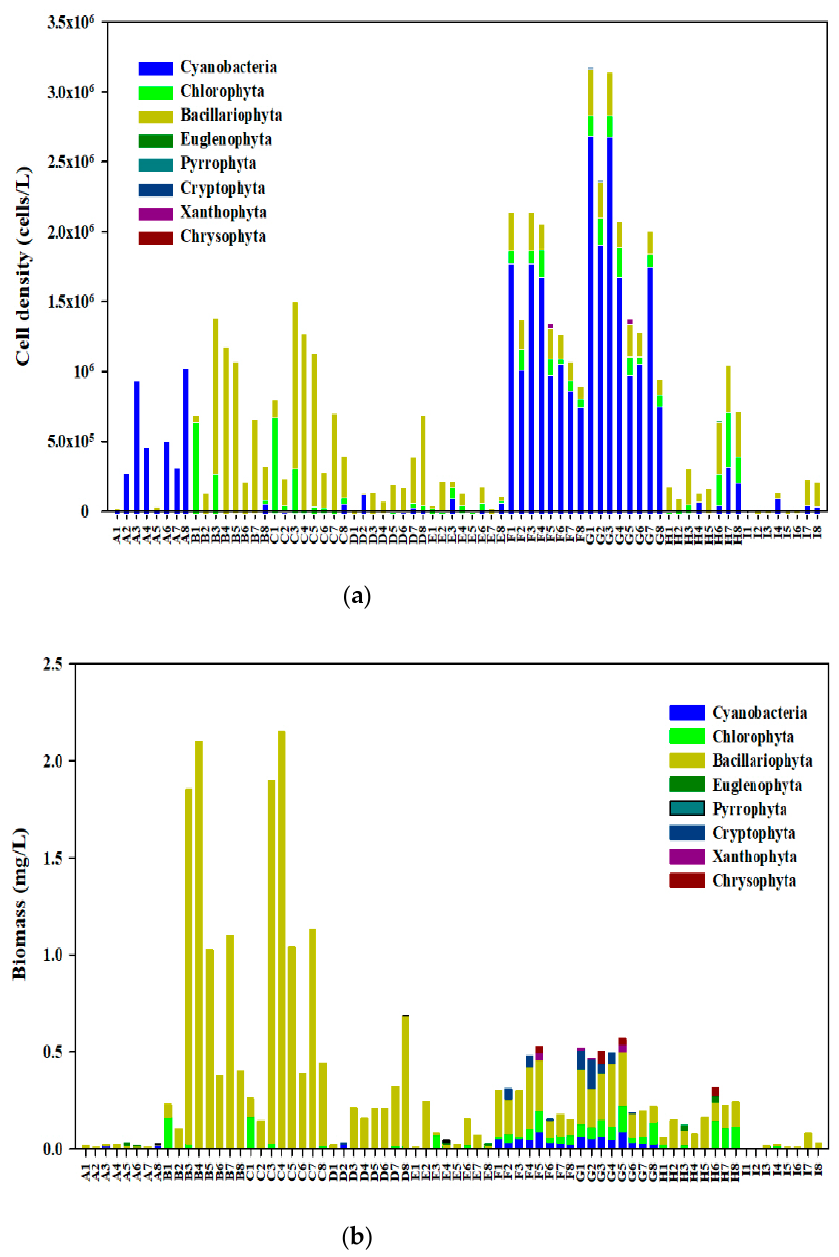
Figure 2. Variation of algae density ( a ) and biomass ( b ) in the reservoir. The dominance (Y) analysis of the dominant phytoplankton species showed that the dominant species changed throughout the period from April to December (Table 2). The dominant algae species mainly belonged to Cyanophyta, Bacillariophyta, and Chloro- phyta, and the main dominant species were Pseudanabaena sp., Melosira granulata , Cy- clotella sp., and Oedogonium sp. In general, the dominant species at each sampling point of the reservoir were the algae species commonly found in eutrophic water. Table 2. Dominant species of phytoplankton in the reservoir from April to December. Phylum Dominant Species Apr. May Jun. Jul. Aug. Sep. Oct. Nov. Dec.